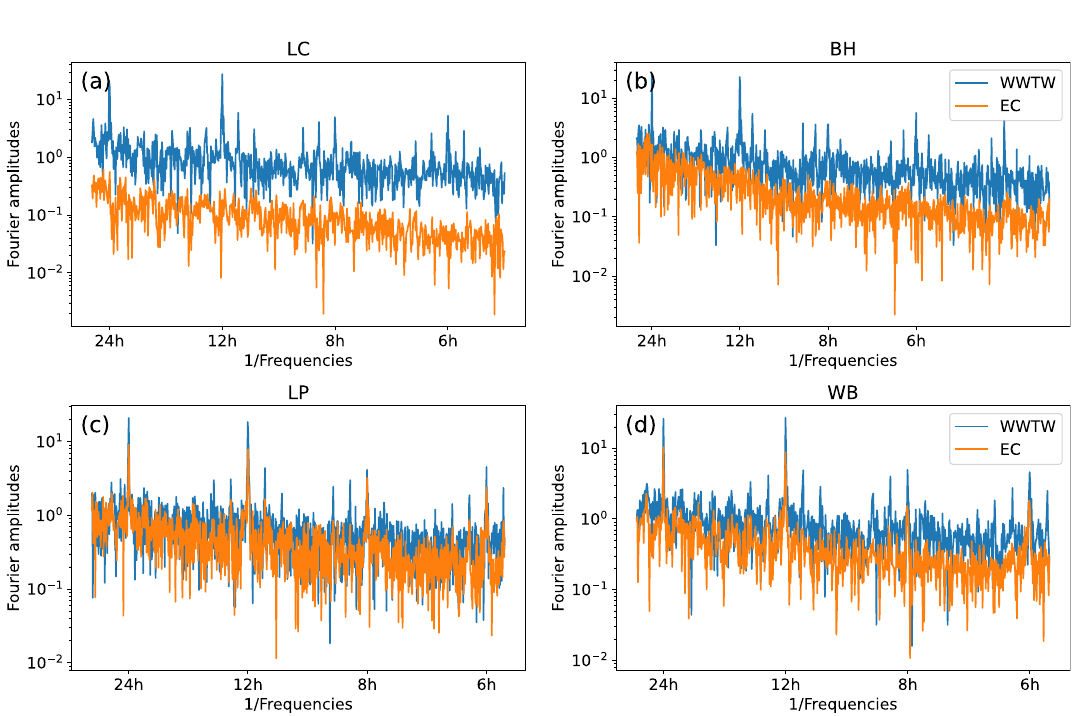
Figure 6. Fourier analysis of wastewater treatment works treated effluent discharge and EC. We plot the Fourier amplitudes of both the electrical conductivity (EC) and the wastewater treatment works (WWTW) discharge at all sites. We note relevant frequency peaks at 24, 12, 8 and 6 hours in the WWTW discharge as well as in conductivity for LP and